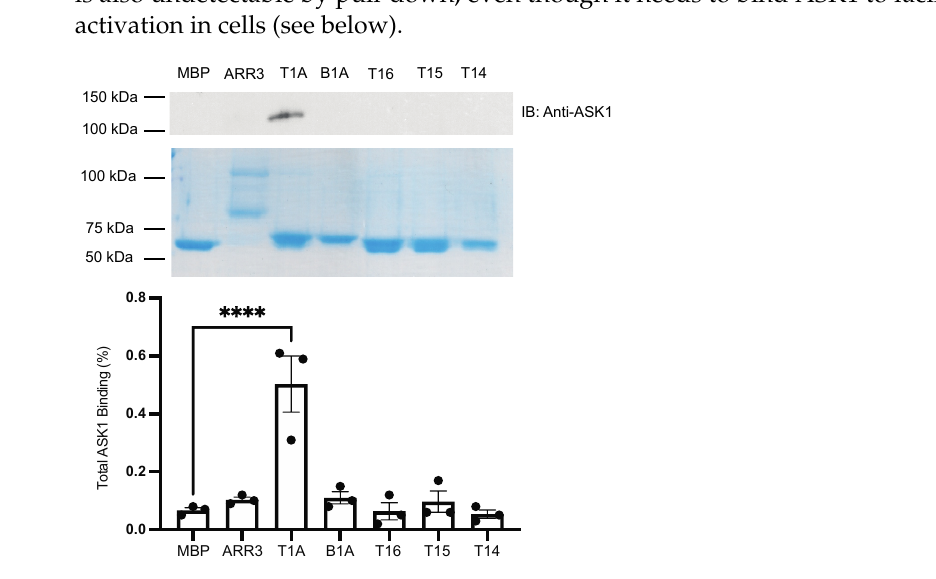
Figure 2. MBP pull-down of ASK1. Purified MBP fusions of indicated peptides and full-length arrestin-3 (10 µ g) were immobilized on amylose resin and incubated with purified ASK1 (5 µ g), as described in the methods. The beads were washed, and bound proteins were eluted with 50 mM maltose. Aliquots of eluates were subjected to SDS-PAGE. Coomassie staining (middle panel) was used to assess the loading of MBP constructs. Double bands of MBP-peptides and MBP-arrestin-3 here and in Figures 3–5 likely result from proteolysis of purified proteins. ASK1 binding was measured by Western (top panel). Densitometric quantification (bottom panel) was performed using ImageJ software [26]. Dots represent measurements in individual experiments. Statistical analysis was performed using one-way ANOVA followed by Dunnett’s post hoc test with correction for multiple comparisons ( n = 3). ****, p < 0.0001.